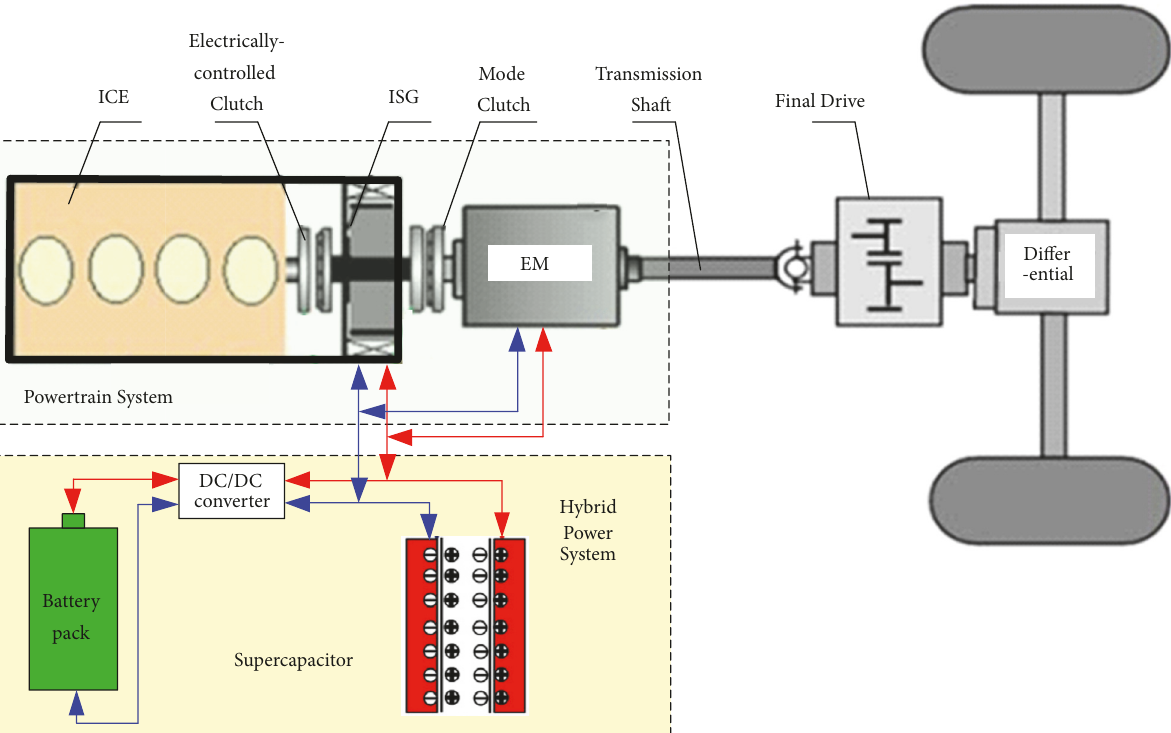
Figure 8: The configuration of the single axis parallel-series